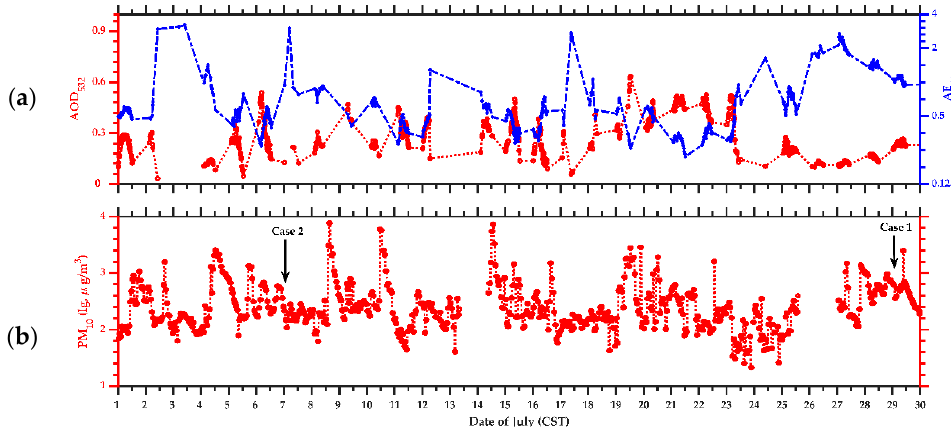
Figure 4. ( a ) AOD 532 and AE 470–870 obtained from a sun photometer in July of 2019. The X -axis indicates the days of July in China Standard Time (CST); ( b ) PM 10 mass concentration in July of 2019. The X -axis indicates the days of July in CST, and the Y -axis represents the PM 10 ( µ g m − 3 ). Note that the color scale has been converted to log PM 10 for better visualization.